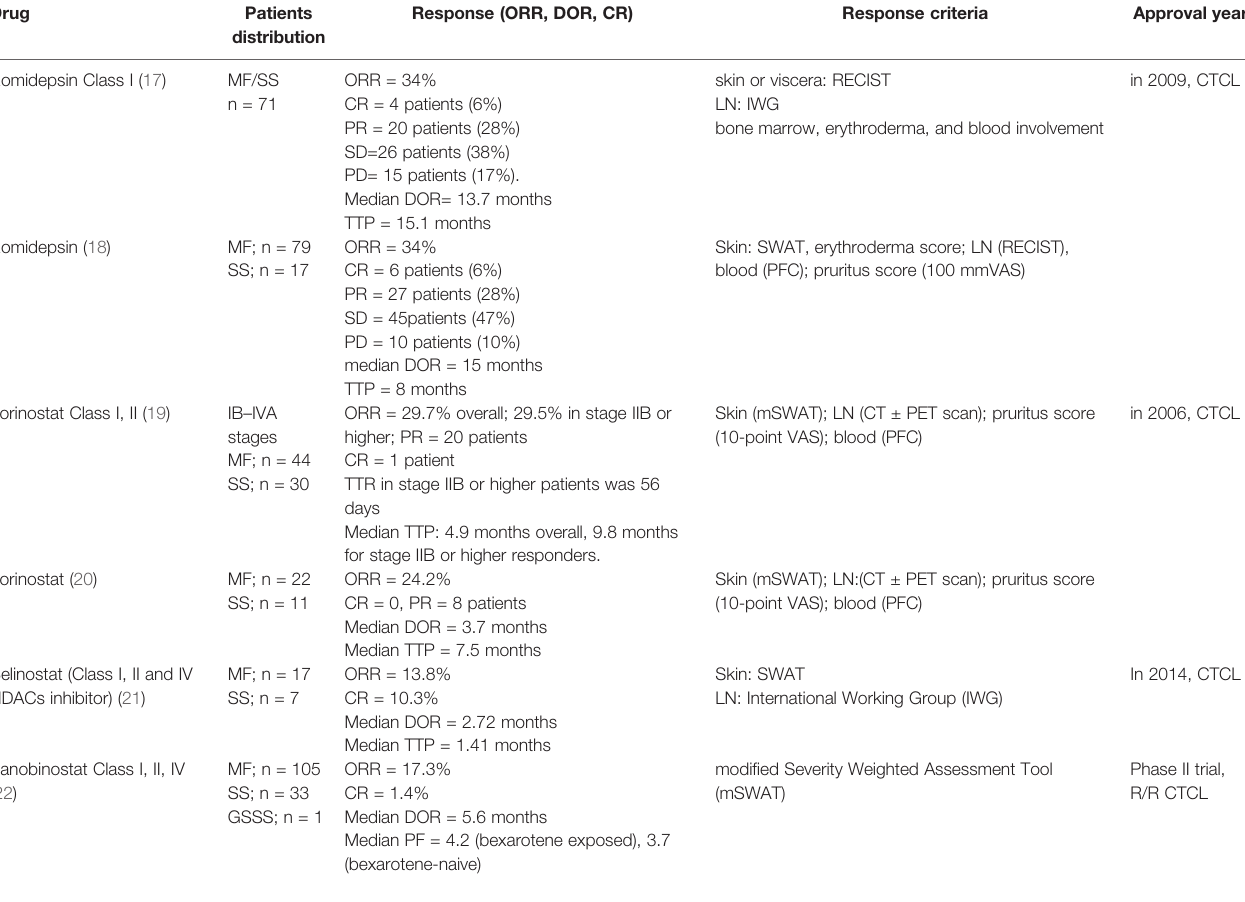
TABLE 1 | Clinical effects of HDAC Inhibitors in Cutaneous T − cell Lymphoma [refer to Adriana T. Lopez et al. (13)].